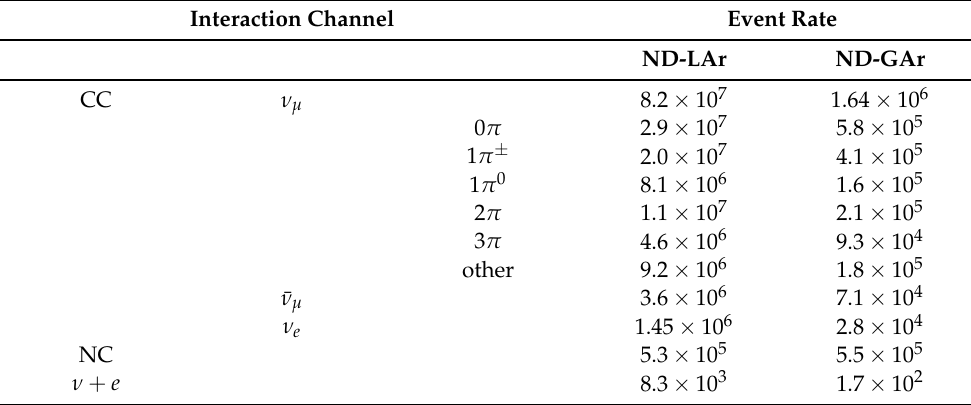
Table 21. Events per year (1.1 10 21 POT) in the forward horn-current ( ν µ -favoring) mode. The rates × were computed with GENIE 2.12.10. The rates assume a 50t fiducial volume of liquid argon and a 1t fiducial volume of argon gas. Interaction Channel Event Rate ND-LAr